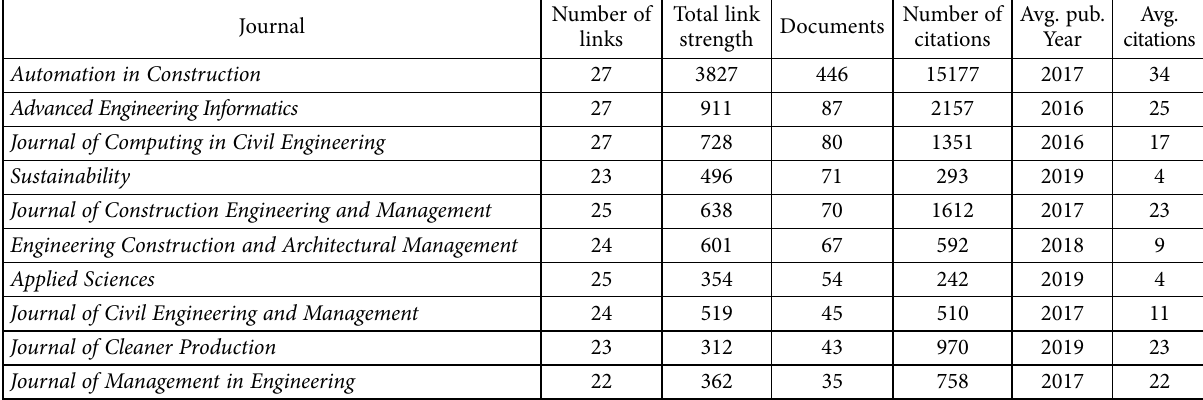
Figure 5. Co-occurring keywords network Table 4. Citations analysis of highly influential journals in BIM